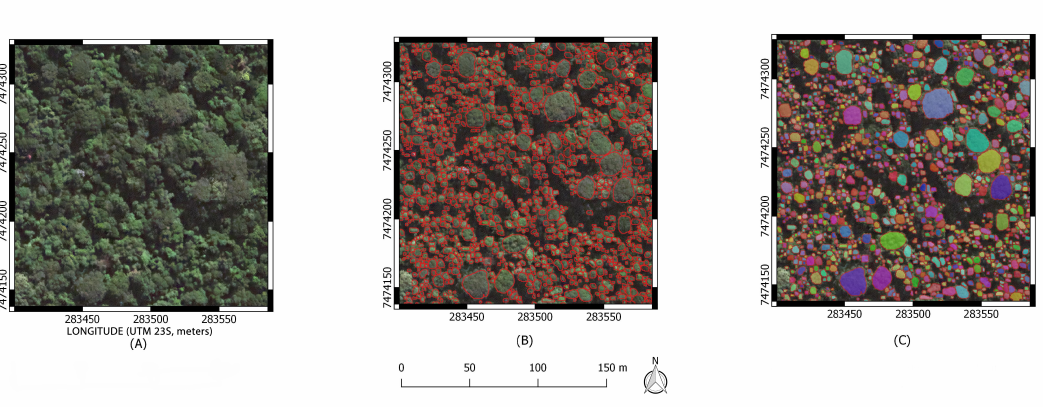
Figure 14. Result of the application of Mask R-CNN to perform the TCDD. ( A ) The test region from the Santa Genebra Reserve image; ( B ) The result of tree crown delineation in red; ( C ) The identification of each tree crown, each fill color represents an ID provided by Mask